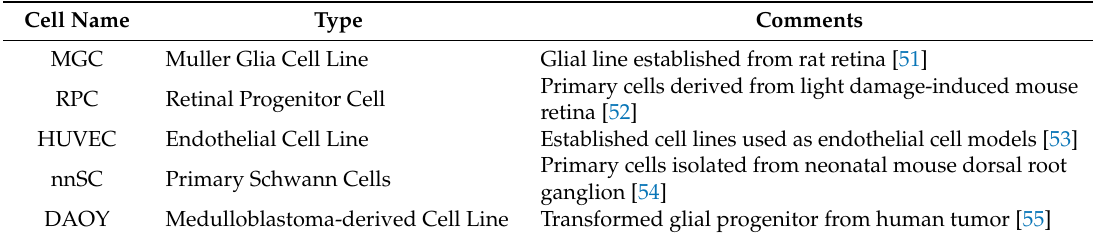
Table 1. Summary of Cells